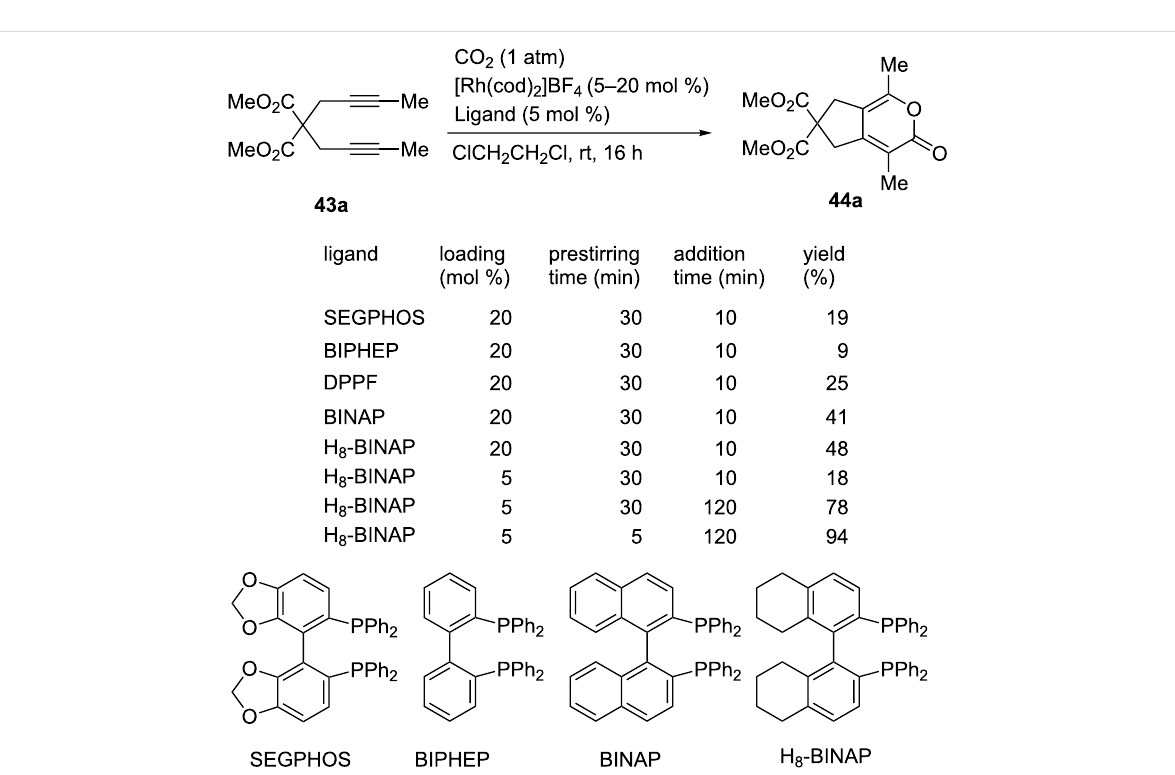
C (step b), from which reductive elimination occurs to yield its corresponding pyrone and the Rh(I) species A (step c). Alterna- tively, the oxidative cyclization of A proceeds as one of the C–C triple bonds of the diyne and CO 2 react